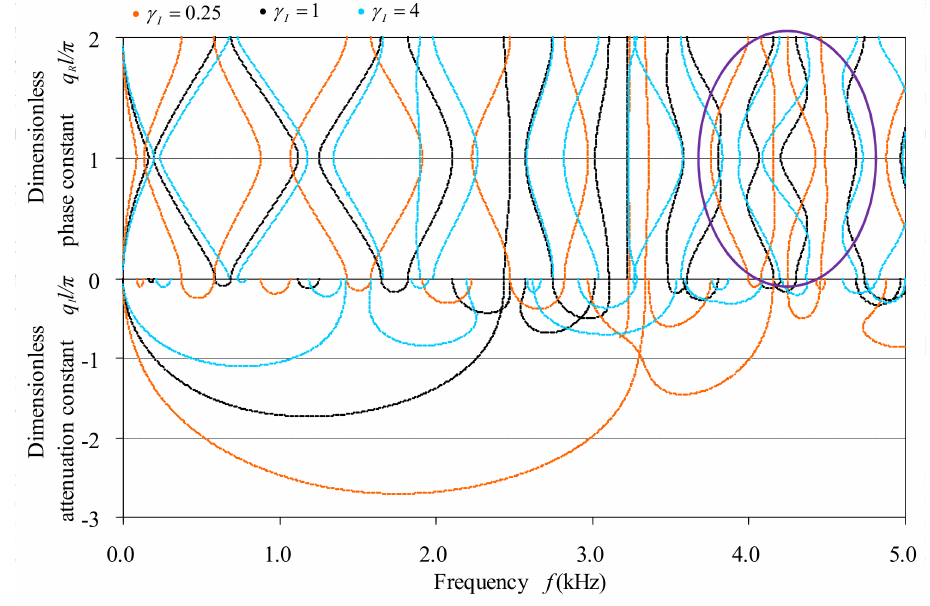
Figure 10. Effect of the inertia moment of constituent beam on the band structures of the bi-coupled periodic beam with Ternary-I unit